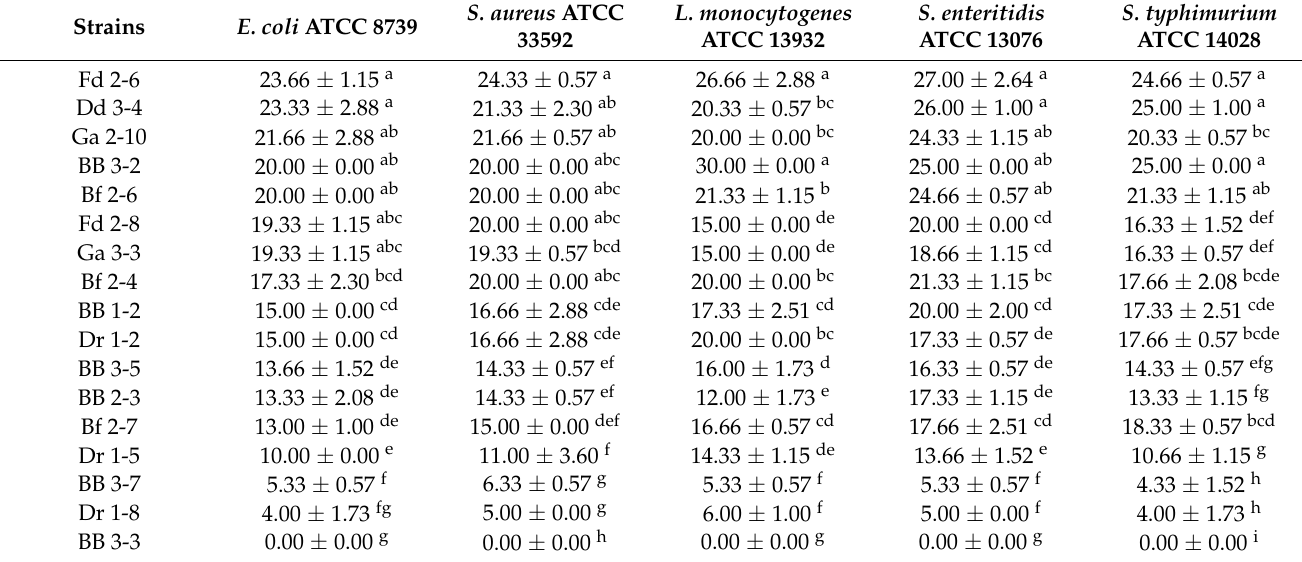
Table 4. Antibacterial activities of the yeast strains (inhibitory zones in mm).